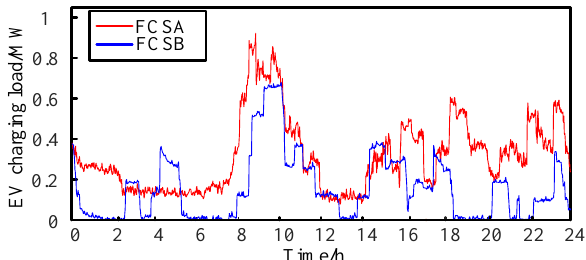
Figure 6. Typical daily EV charging curves of FCSs A and B in a day.